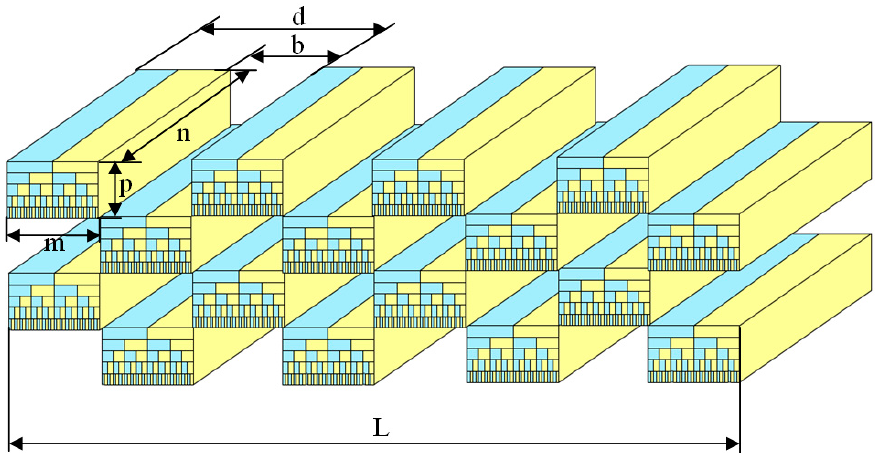
Figure 6. Reflective screen of fractal structure.